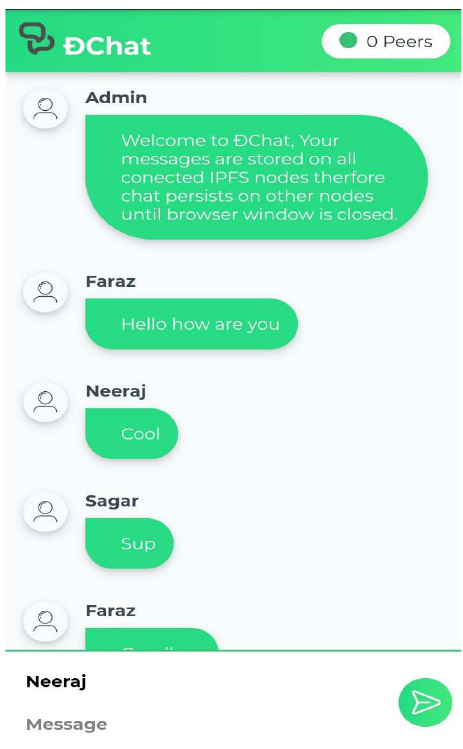
Fig. 4. Snapshot of the developed DChat application Users have to visit the